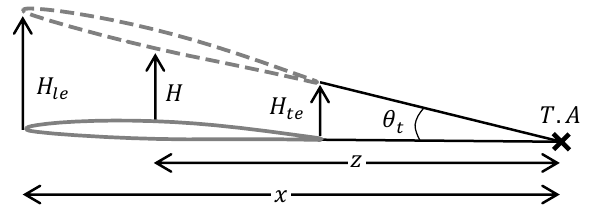
Figure 3. Implementation of 1F mode shape as SDOF